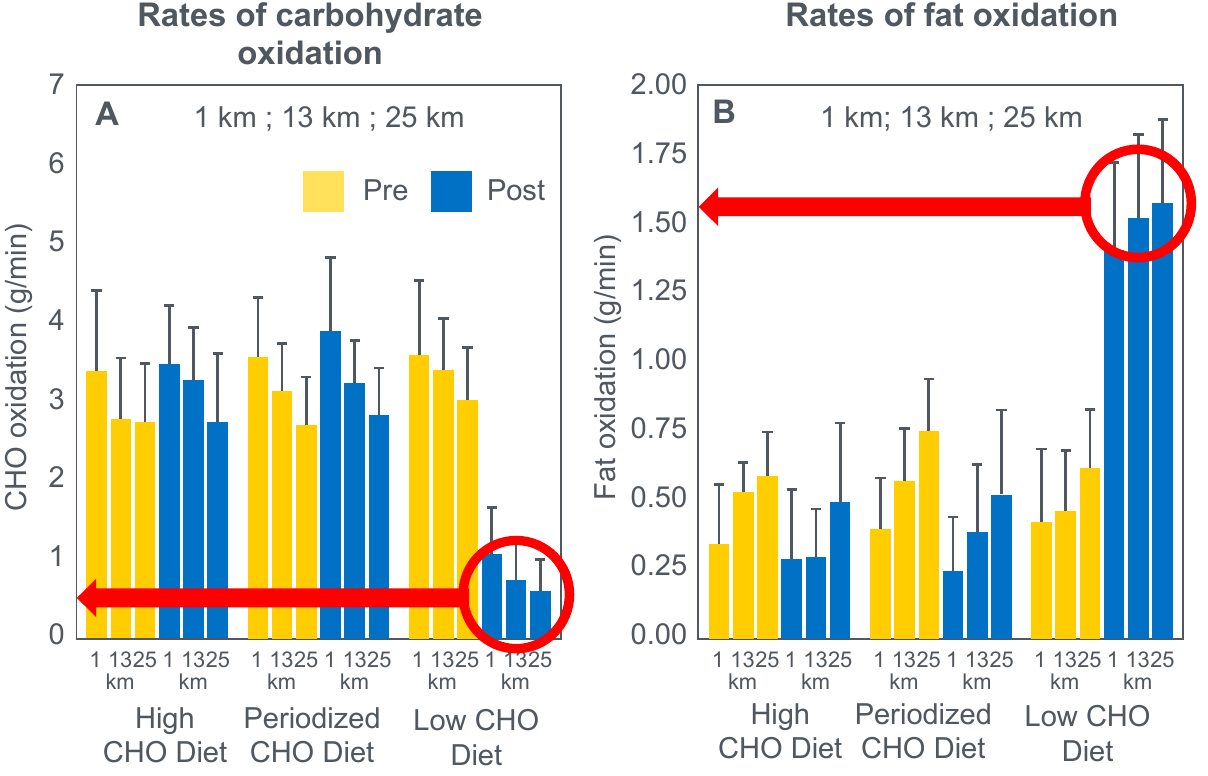
Figure 28. Rates of carbohydrate (panel A ) and fat oxidation (panel B ) measured at 1, 13 and 25 km in race walkers during two 25 km time trials before and after they had adapted to one of three different dietary options—high-carbohydrate diet; a periodized carbohydrate diet; and a low-carbohydrate high-fat diet. Adapted with permission from ref. [134]. Copy-right 2017 The Physiological Society (John Wiley and Sons).